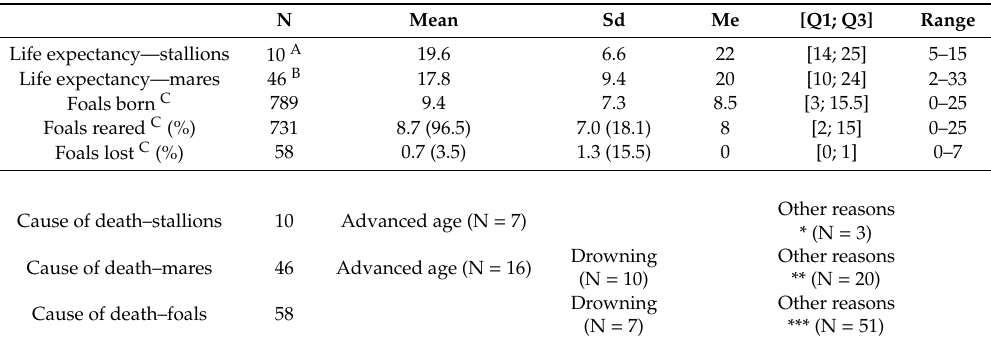
Table 2. Life expectancy, reproductive e ffi ciency of mares, and causes of death of Konik horse stallions, mares, and foals reared up to 1 year old. N Mean Sd Me [Q1;